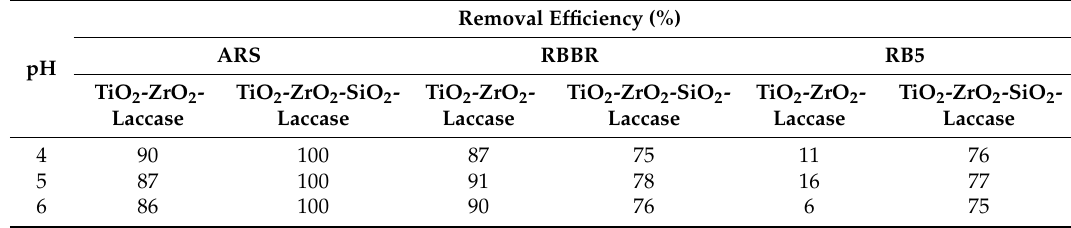
Table 3. Removal efficiencies of dyes from solutions at different pH after 24 h of the process (concentration of dye solution 5 mg/L, temperature 25 ◦ C). The errors of all measurements do not exceed